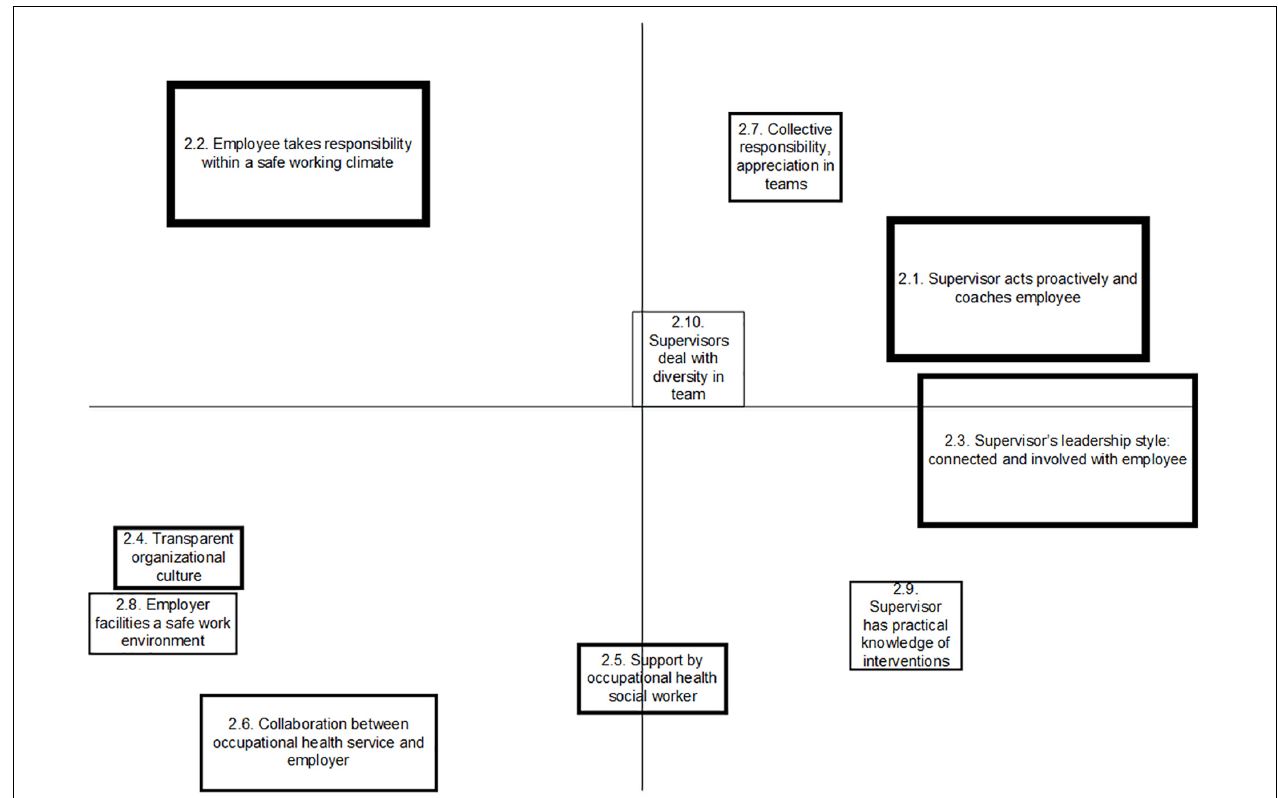
FIGURE 2 | Concept map on factors promoting Stay at work, representing the perspective of